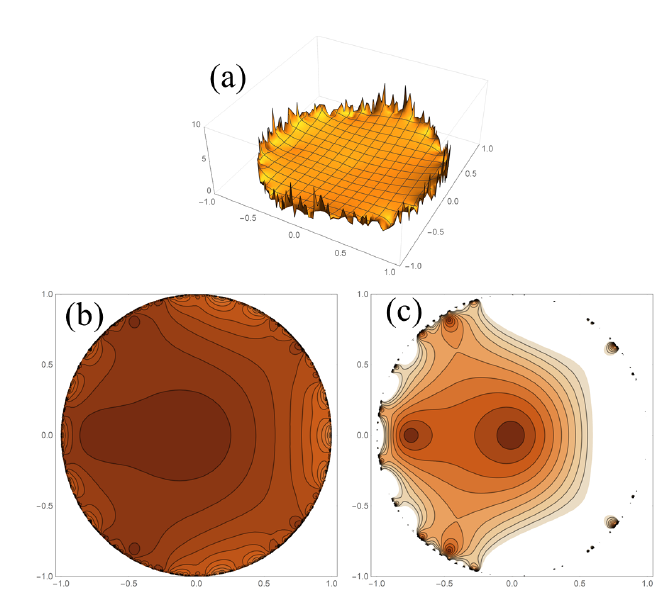
z n ! . To render the plot an upper limit, N , on the sum must Figure 1. The example of f ( z ) = ∑ ∞ n = 1 be chosen. In this case, N = 40. Panel ( a ) is the three-dimensional graph of | f ( z ) | . Panel ( b ) shows the corresponding contour plot. Panel ( c ) is a particularly important representation. In this case, the contour plot is limited to | f ( z ) | ≤ 1. The contour at | f ( z ) | = 1 is referred to as the unity contour. The part of the unity contour which is a closed curve encircling the origin is called the main unity contour (see Definition